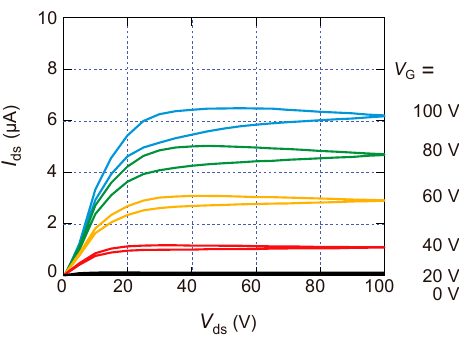
Figure 5. Current–voltage characteristics of the F 8 CuPc n-channel transistor in vacuum (~10 2 Pa).